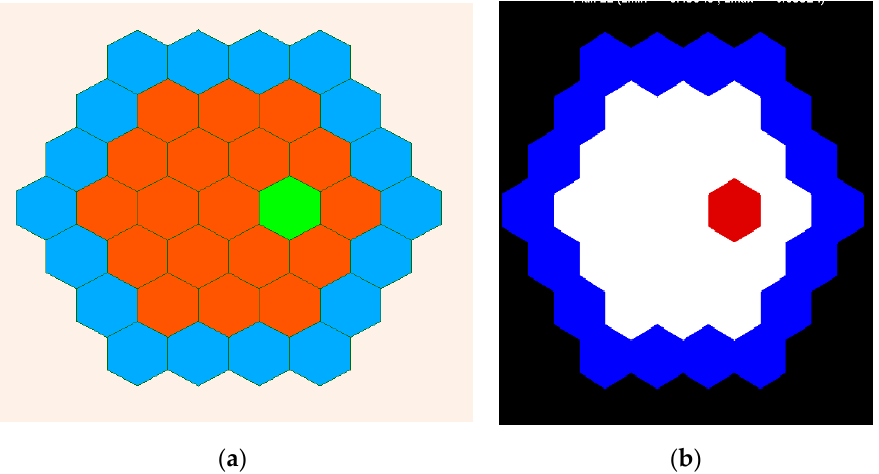
Figure 26. The 19 Hexagonal FA core case: ( a ) Scenario A; hexagonal case: Scenario A; ( b ) APOLLO3 ® model; APOLLO3 ® model.